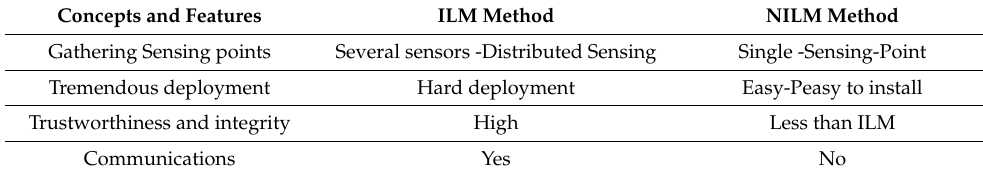
Table 5. NILM vs.